Question: Compose a caption that would accompany this figure in a paper.
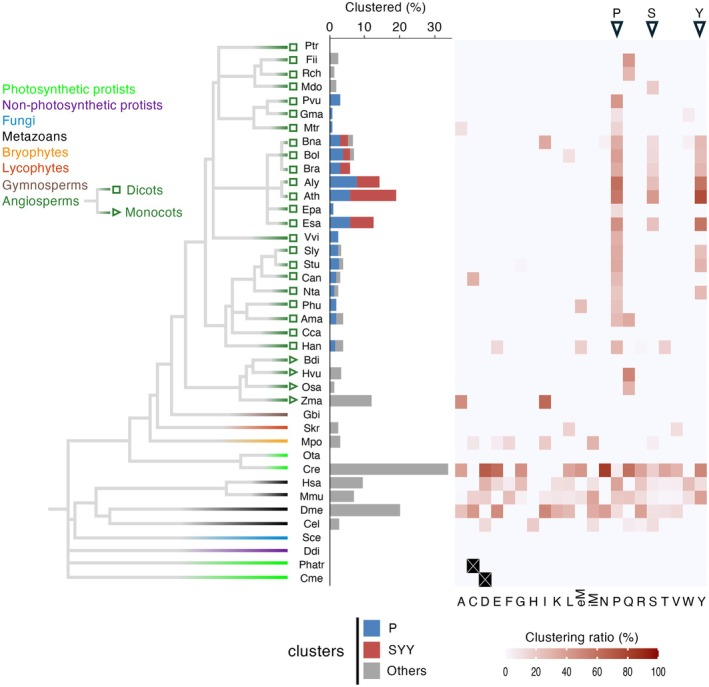
Answer: Comparative analysis of tDNA clustering across species and isotype families. Histogram showing the percentage of total clustered tDNAs in each species (left) and heat map showing the clustering ratio of tDNA isotypes in each species (right), under the clustering criterion ≥5 genes within 5 kb. White indicates the absence of clustering (all genes isolated), whereas dark red indicates complete clustering (all genes grouped), with the color scale representing clustering ratio (%) from 0 to 100. White arrows point to three tDNA isotype families (proline/P, serine/S, and tyrosine/Y) that frequently cluster in angiosperms (see blue and red histogram). In Cyanidioschyzon merolae (Cme) and Phaeodactylum tricornutum (Phatr), asparagine (D) and cysteine (C) tDNAs could not be confidently annotated and were excluded from the analysis (black crossed‐out boxes). Complete results for all clustering criteria are provided in Figure S10 .